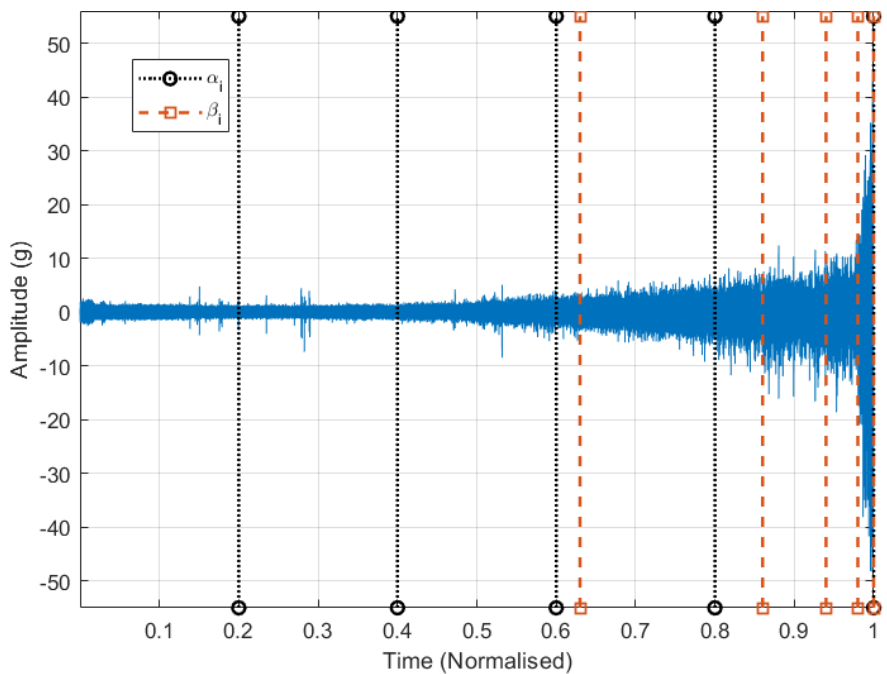
Figure 5. Linear and non-linear wear-state class boundaries, α i and β i ,